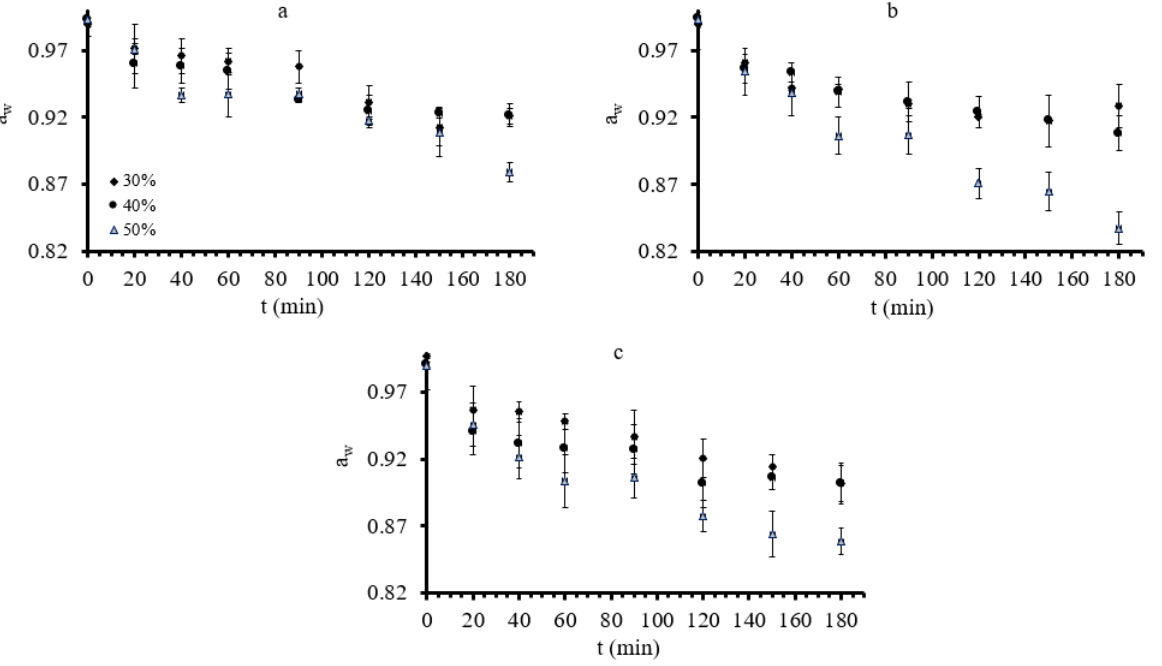
Figure 1. ( a – c ): a w during osmotic dehydration at 30, 40, and 50 °C, respectively, at all three different glycerol concentrations. Points represent average values, and error bars represent the standard deviation, as calculated from the three measurements.